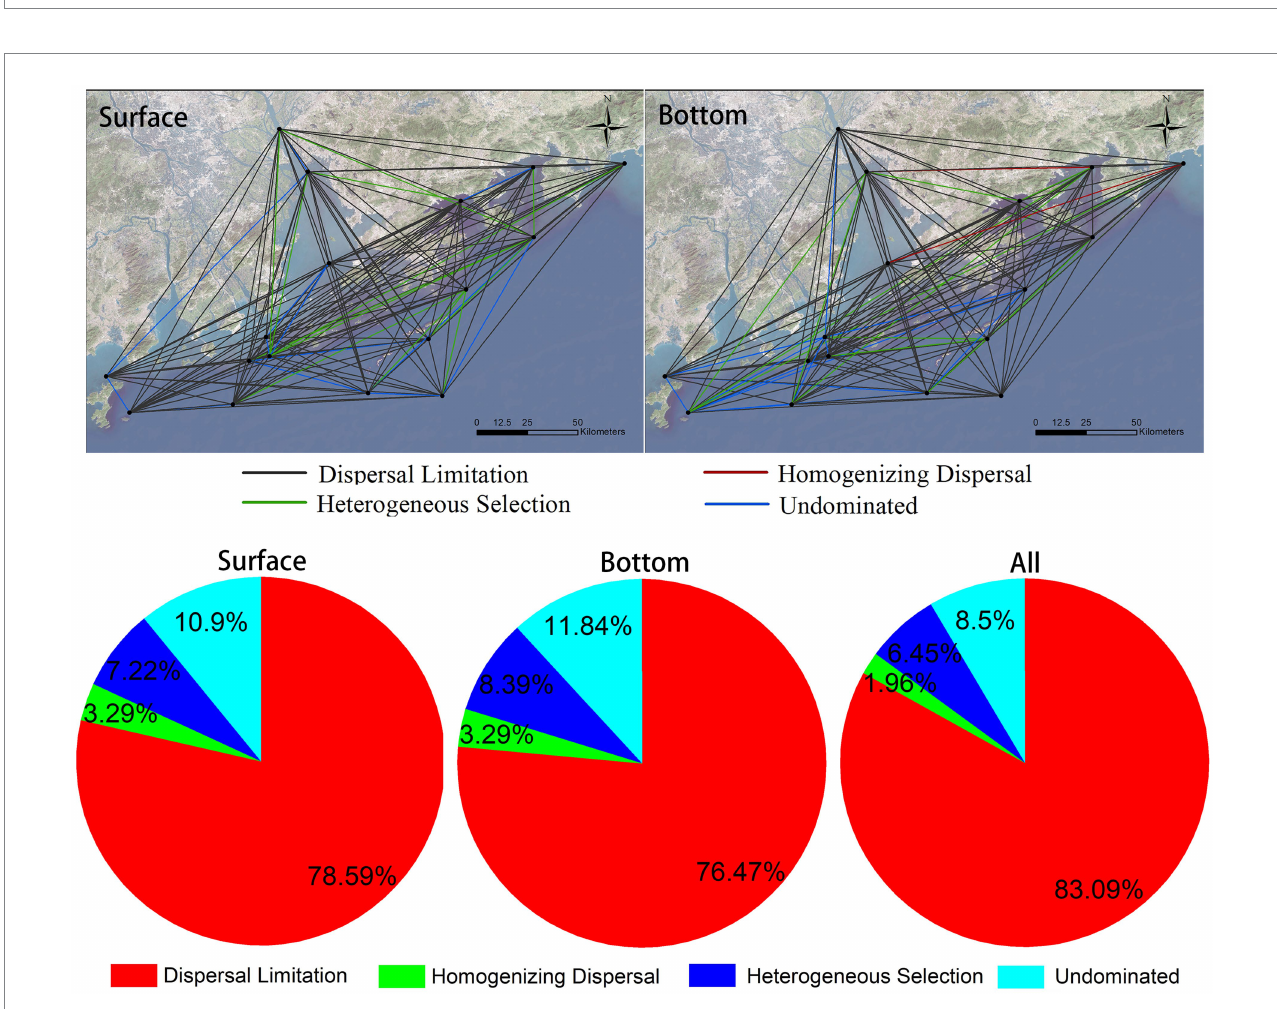
FIGURE 7 Eukaryotic plankton community assembly mechanisms in coastal waters of the Greater Bay Area, illustrating leading rule of stochastic processes (dispersal